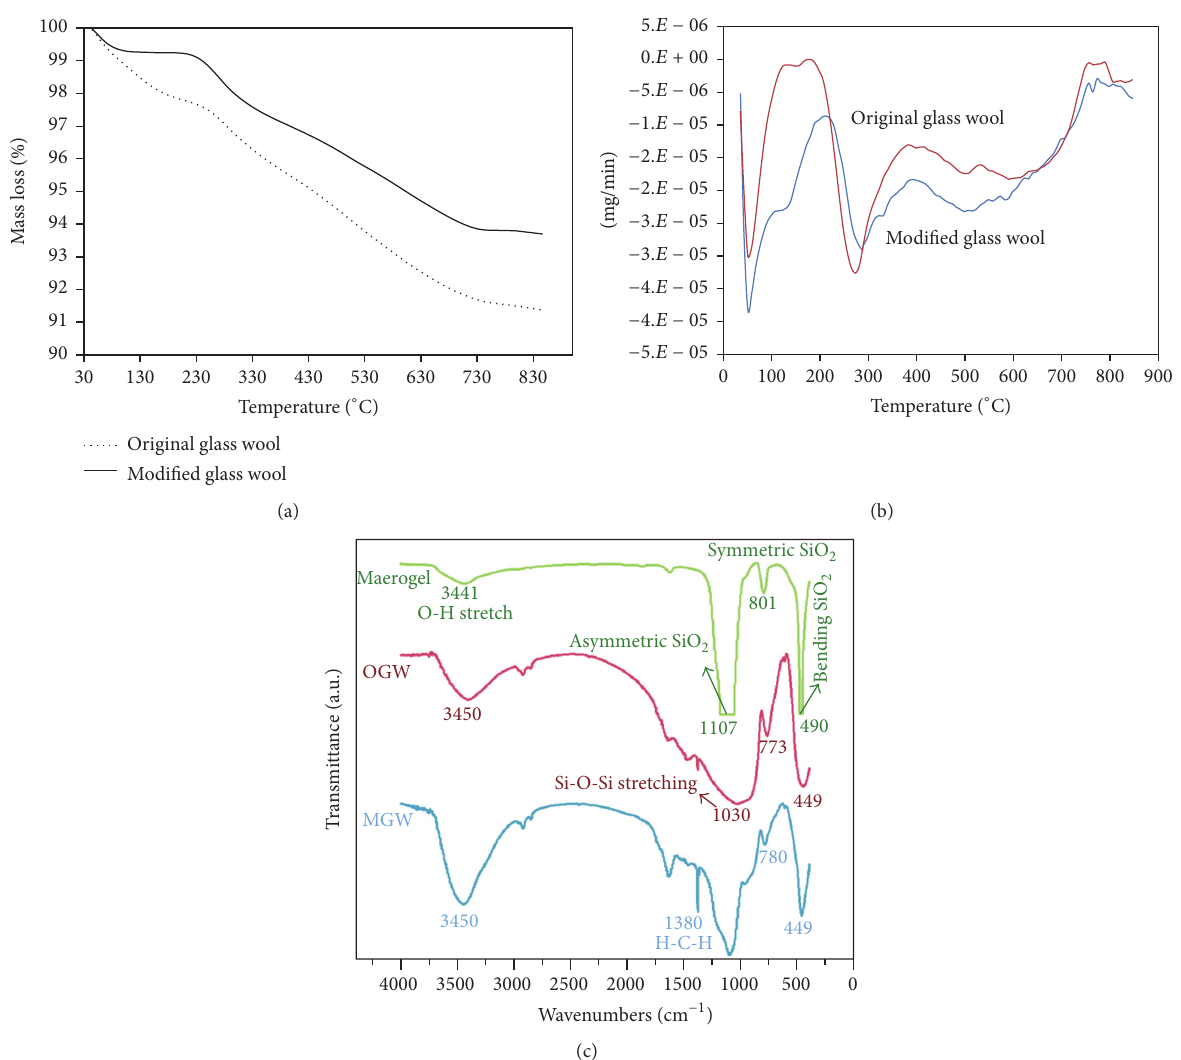
Figure 1: TGA (a). DTG (b). and FTIR (c). Comparison between original glass wool (OGW) and modified glass wool (MGW).